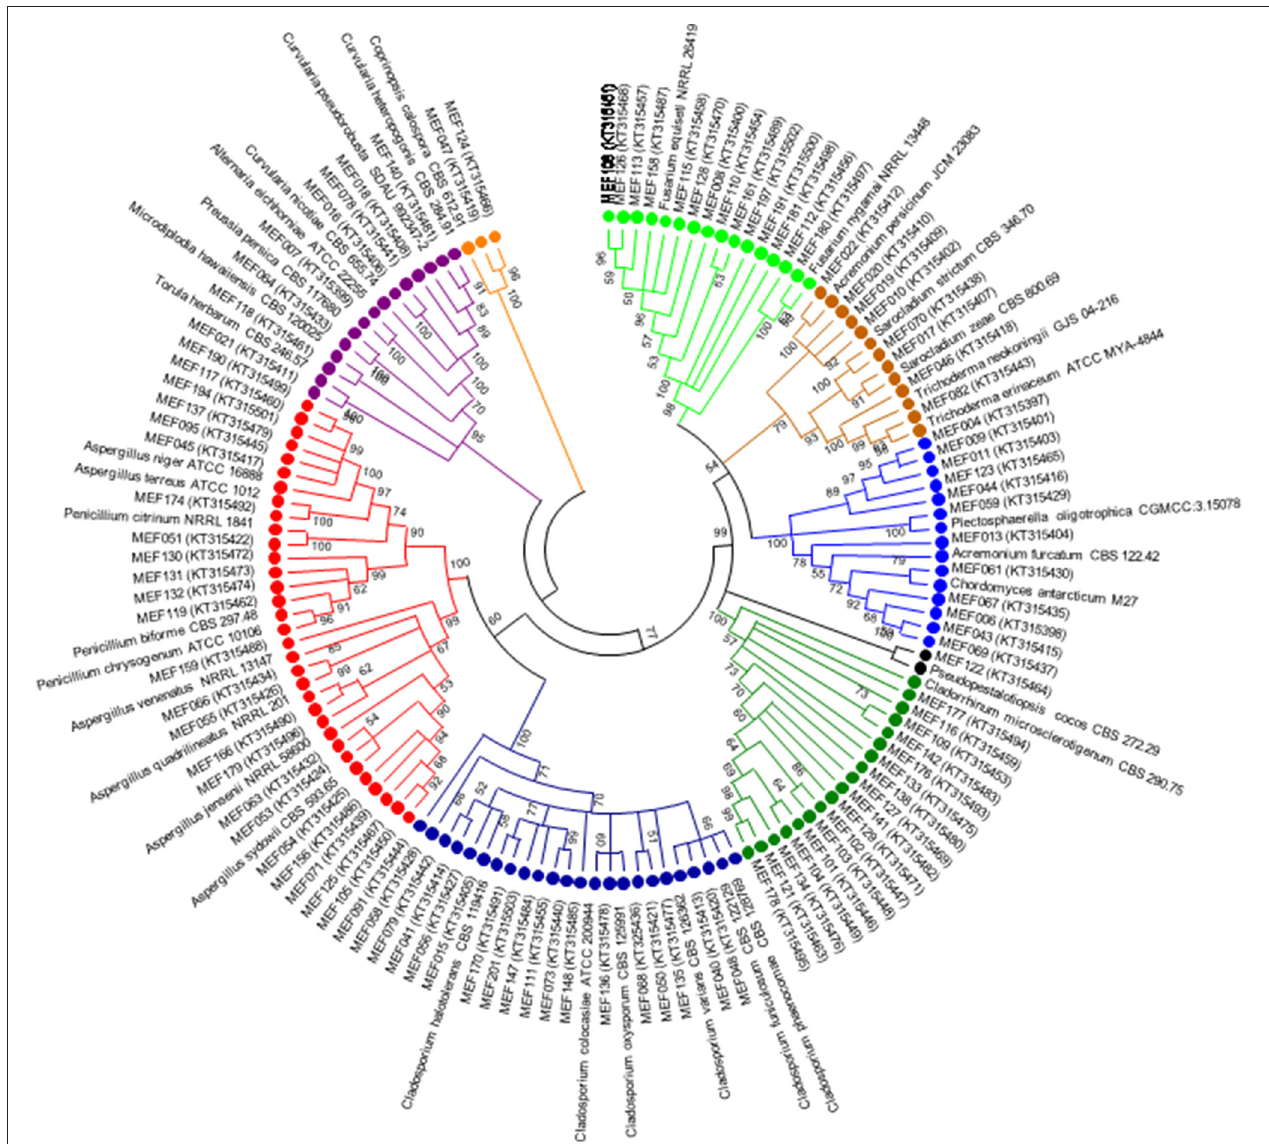
FIGURE 2 | Phylogenetic tree constructed using ITS sequences of 104 isolated strains of fungi along with homologous sequences from type strains of closest match in GenBank. The evolutionary history was inferred using the neighbor-joining method. The optimal tree with the sum of branch length = 3.96668506 is shown. The evolutionary distances were computed using the Kimura 2-parameter method (Kimura, 1980) and are in the units of the number of base substitutions per site. The analysis involved 139 nucleotide sequences. There were a total of 659 positions in the final dataset. Evolutionary analyses were conducted in MEGA5 (Tamura et al., 2011). ( Psathyrellaceae ; Pleosporaceae ; Trichocomaceae ; Davidiellaceae ; Lasiosphaeriaceae Amphisphaeriaceae ; Plectosphaerellaceae ; Hypocreaceae ; Nectriaceae